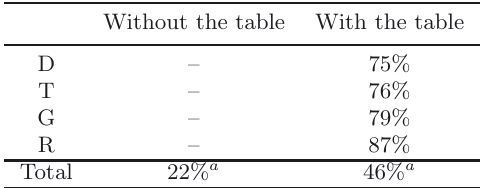
Table 5. Results of the degree of agreement between the ex- perts (in